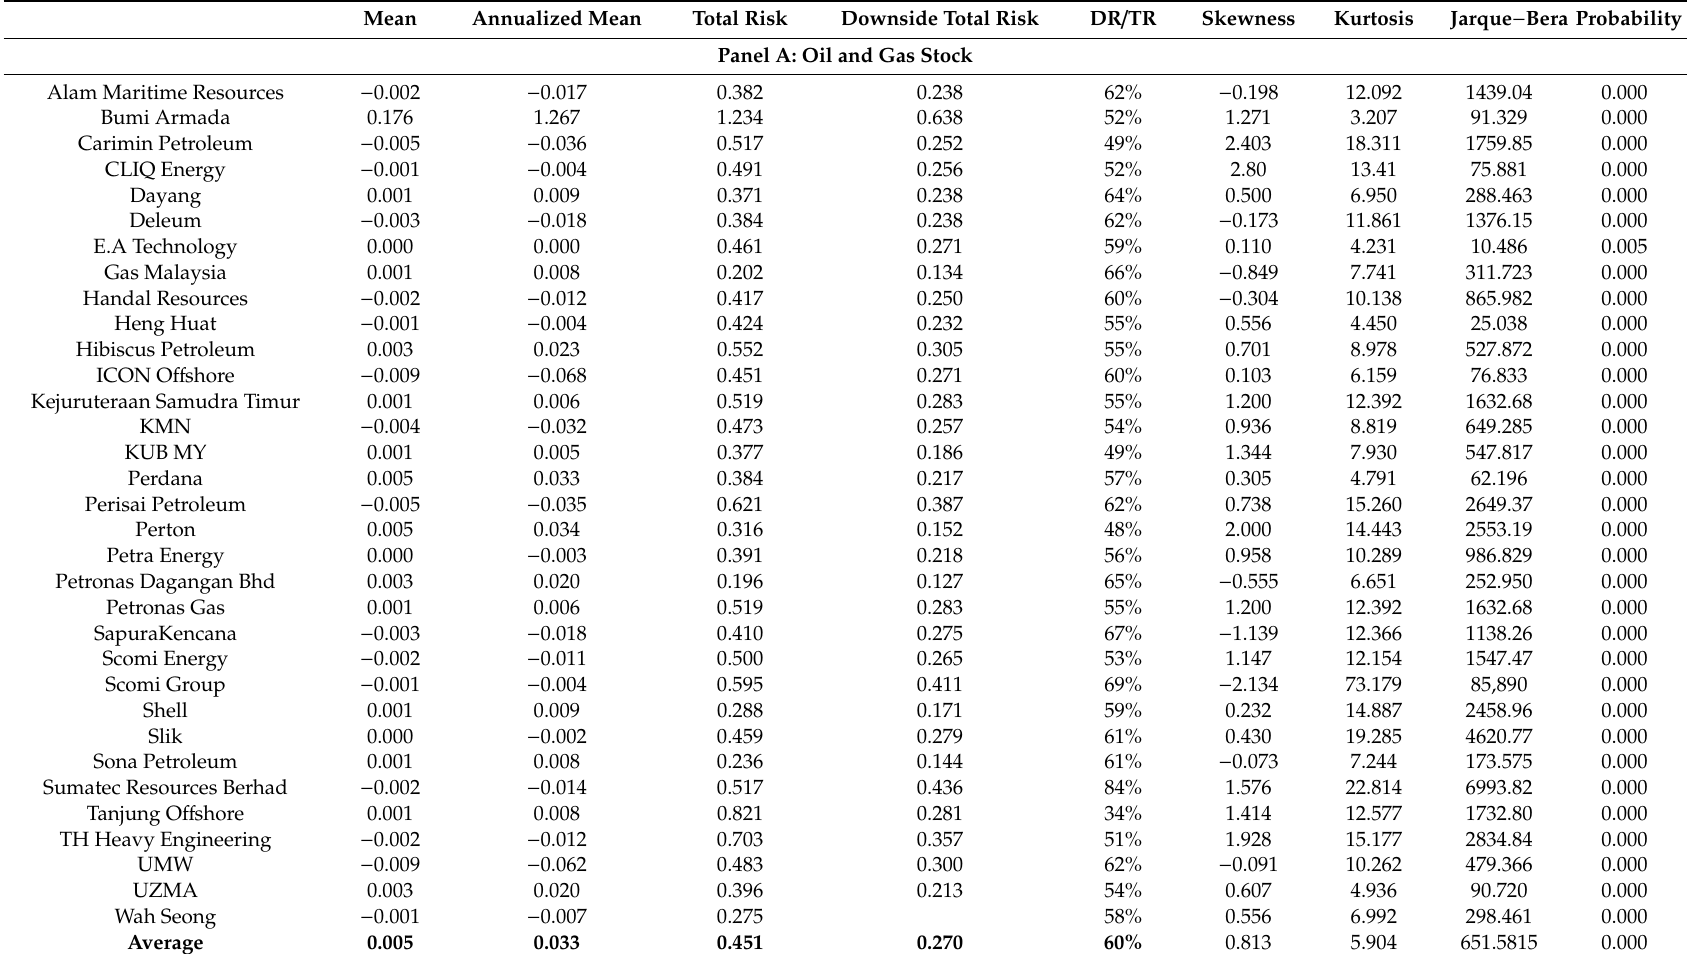
Table 1. Descriptive Statistics and Normality Test of Oil and Gas Stock Returns and Risk